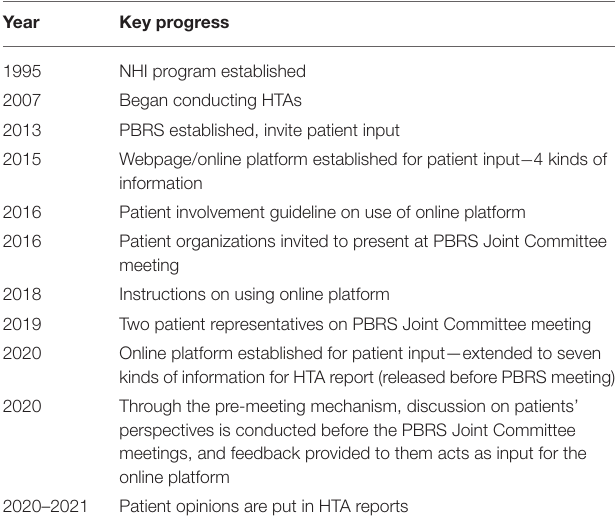
TABLE 1 | The mapping of patient involvement in the health technology assessment process in Taiwan. Key